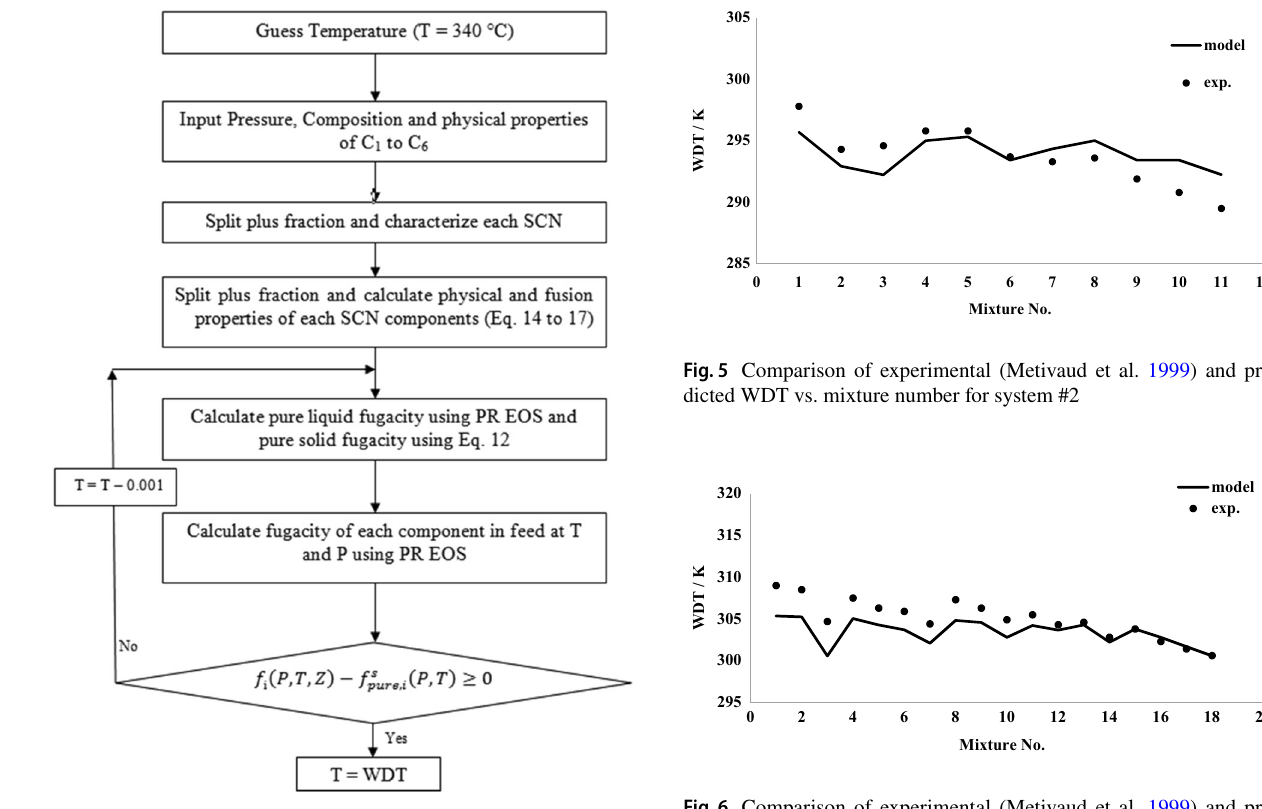
Fig. 3 Algorithm of developing the new MS model for WDT predic- tion